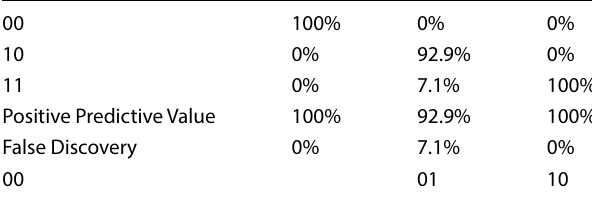
Table 2 Confusion Table for testing dataset based Welch method